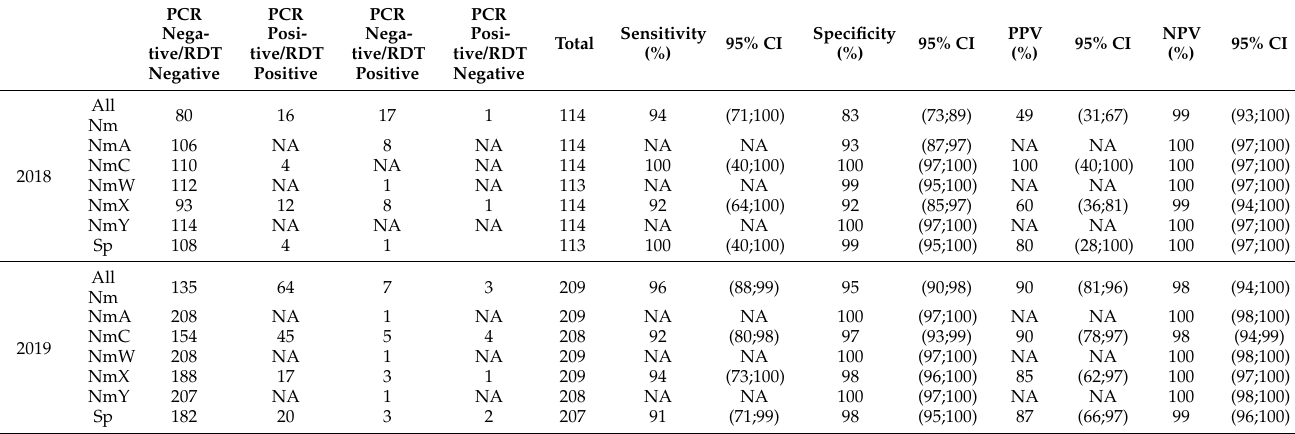
Table 3. Concordance of results obtained by RDT in PHCs with results obtained by PCR in NRLs, and serogroup specific performances, by year of lumbar puncture, Burkina Faso and Niger,